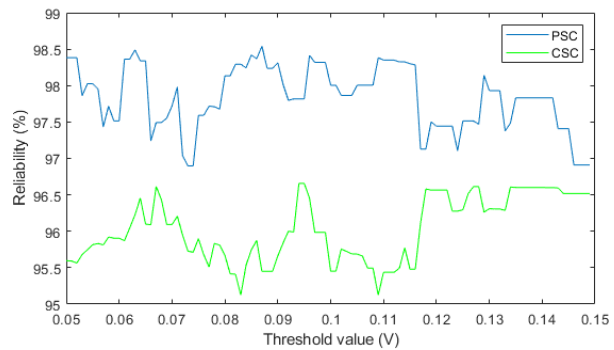
Figure 10. Comparison of the reliability of the keys generated by PSC and CSC for DiffC-PUF data.